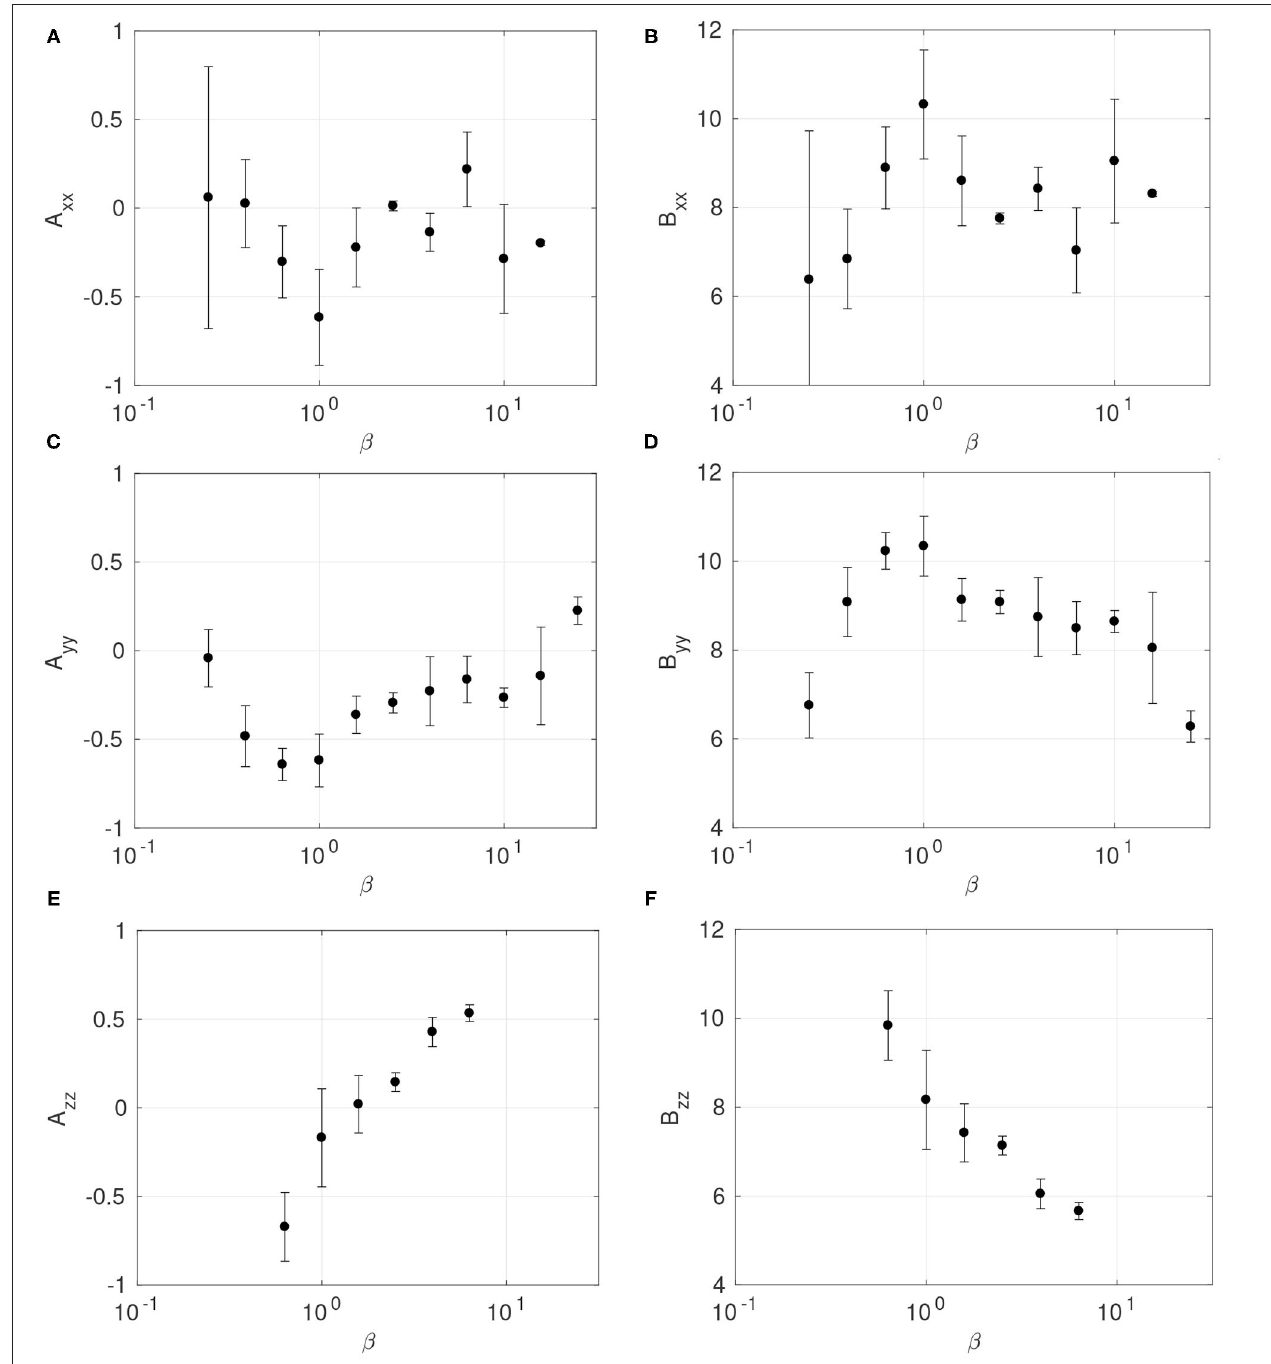
FIGURE 7 | Slopes (A) and intercepts (B) obtained from fits of κ vs. log 10 D data for different β values. The first row (A,B) is for D xx , while the second (C,D) and third rows (E,F) are for D xx and D xx , respectively.